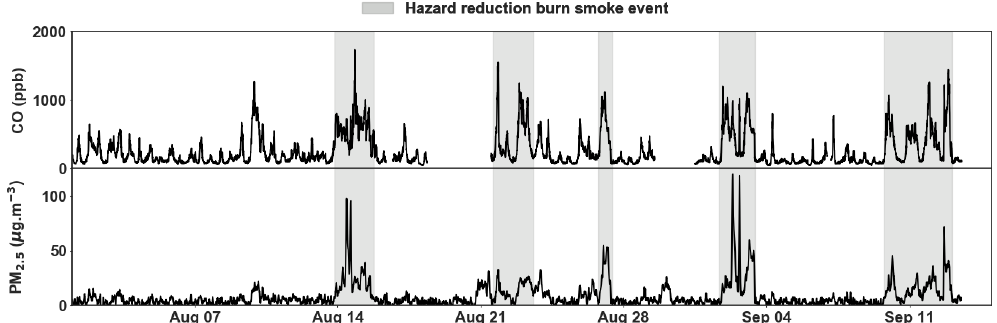
Figure 5. Time series of CO and PM 2.5 during August and first half of September 2017. Shading highlights hazard reduction burn smoke events.